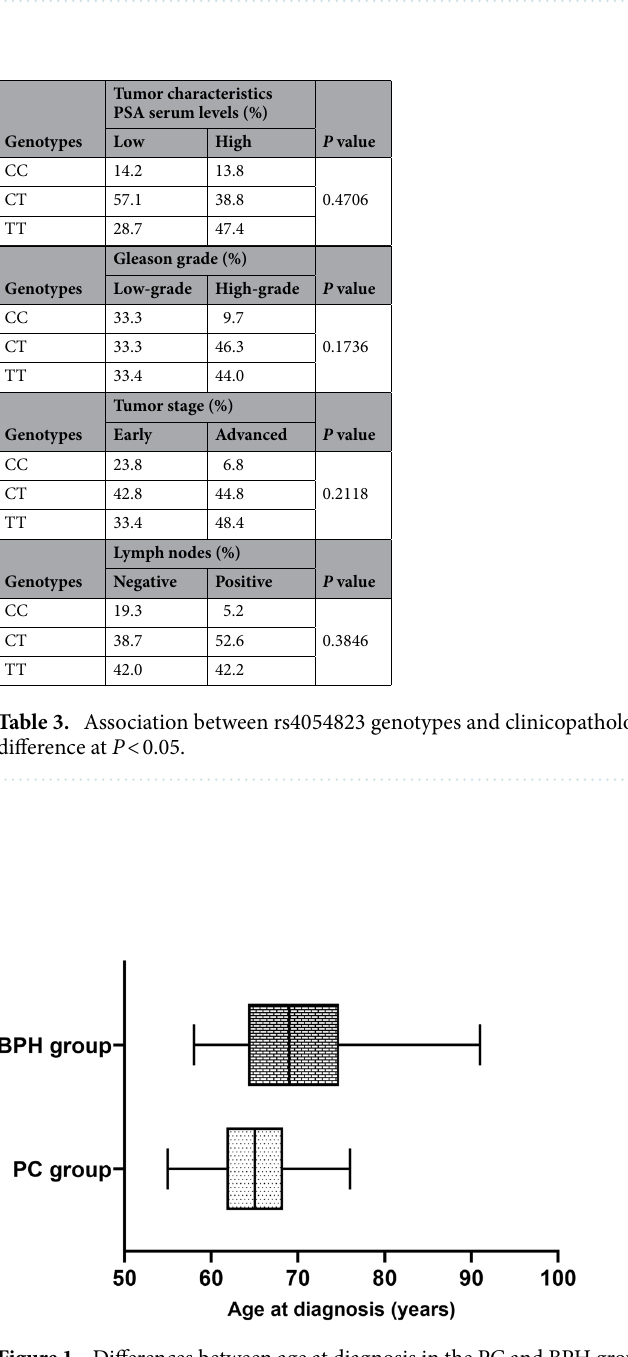
Table 2. Genotype and allele frequency of rs4054823 in patients with PC and BPH. OR: odds ratio. CI: confidence interval. * Significant difference at P < 0.05.